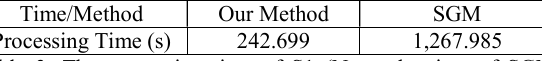
Table 3. The processing time of S1 (Note: the time of SGM including the time of generating epipolar image) 3.2.2 Line Array Image : Every single line of the line array image has different exterior parameters, which means it is troublesome for algorithms using epipolar constraints to match. Two pairs of line array images are used to test the ability of our method to match this type of image. The base image of the first